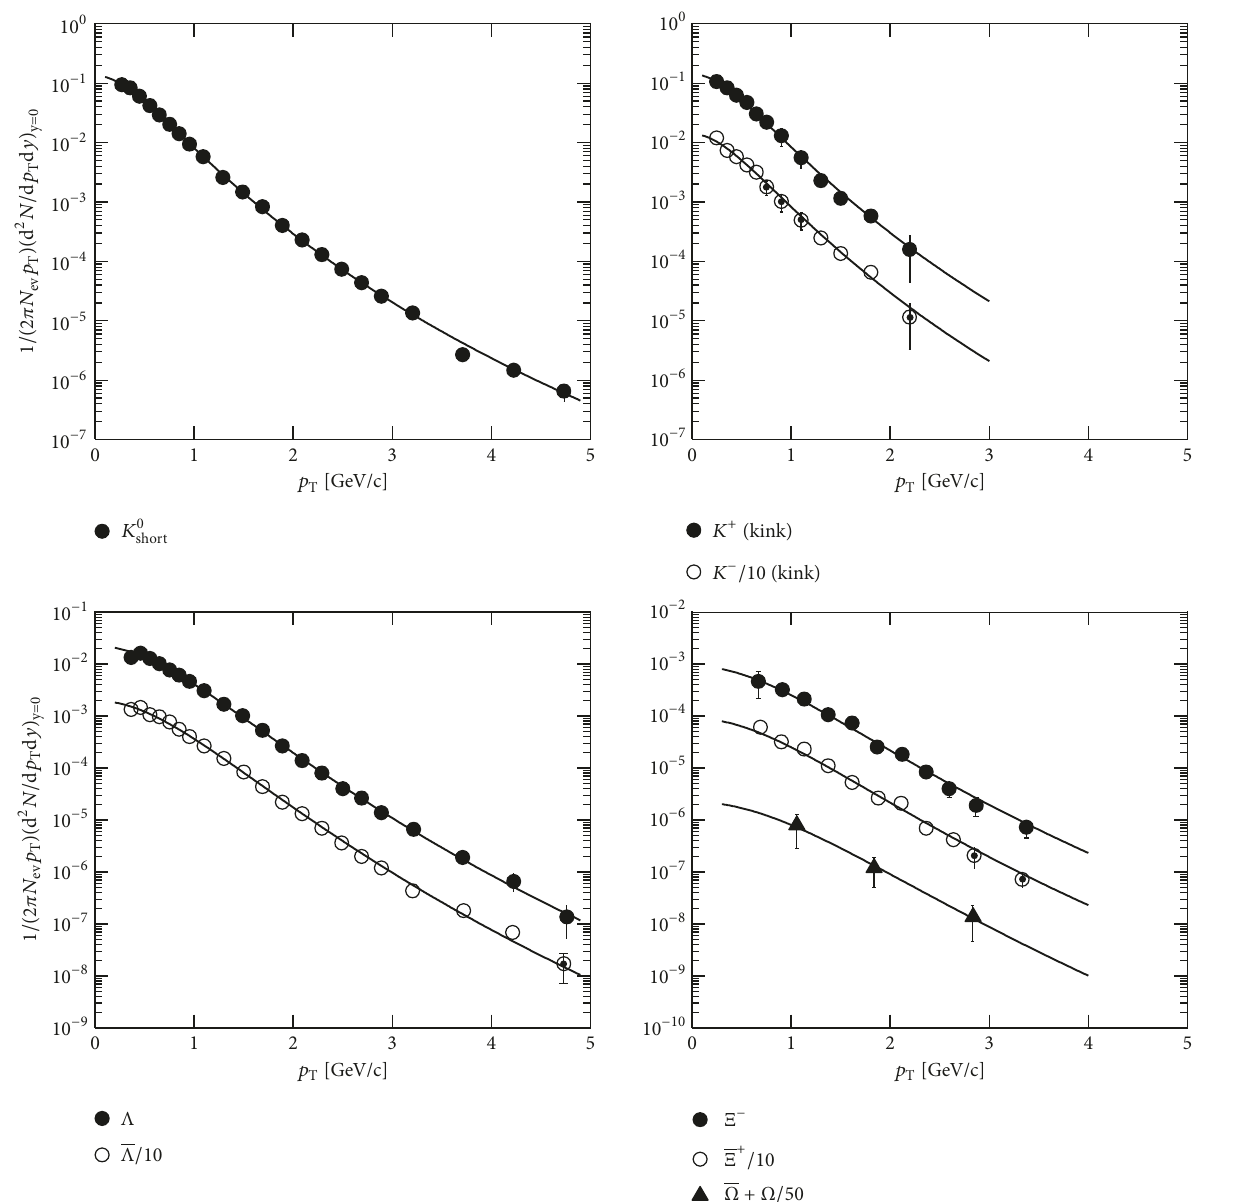
Figure 1: The transverse momentum distributions of strange particles (|𝑦| < 0.5) produced in 𝑝 + 𝑝 collisions at √𝑠 = 200 GeV. The solid dots, circles, and solid triangles represent the experimental data of the STAR Collaboration [44]. The solid curves are the results calculated from Equation (19).